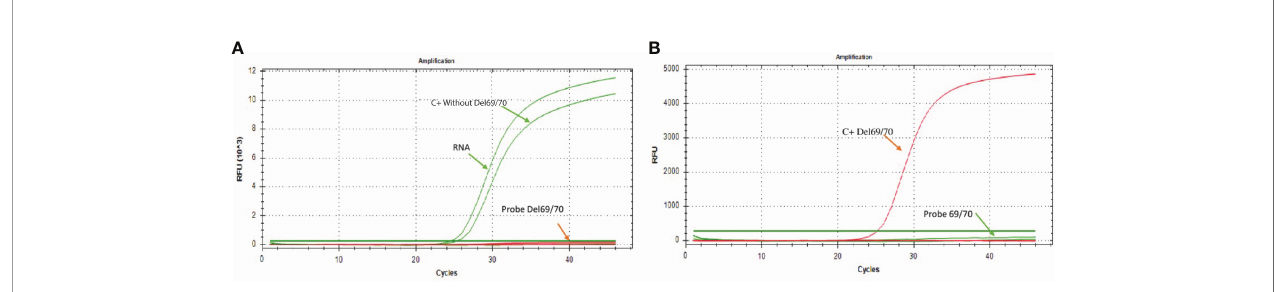
FIGURE 2 | Ampli fi cation curves for the 69/70 assay. (A) The green color curve shows the ampli fi cation of the probe directed to the sequence without deletion (FAM) in a sample of SARS-CoV-2 positive patient; the curve of the probe directed to the sequence that presents the 69/70 deletion remains without signal of ampli fi cation. (B) The red curve shows the probe ampli fi cation directed to the 69/70 deletion (CFR 610) using the synthetic control containing the 69/70 deletion. In contrast, the probe directed to the sequence that does not present the deletion 69/70 remains without ampli fi cation signal.